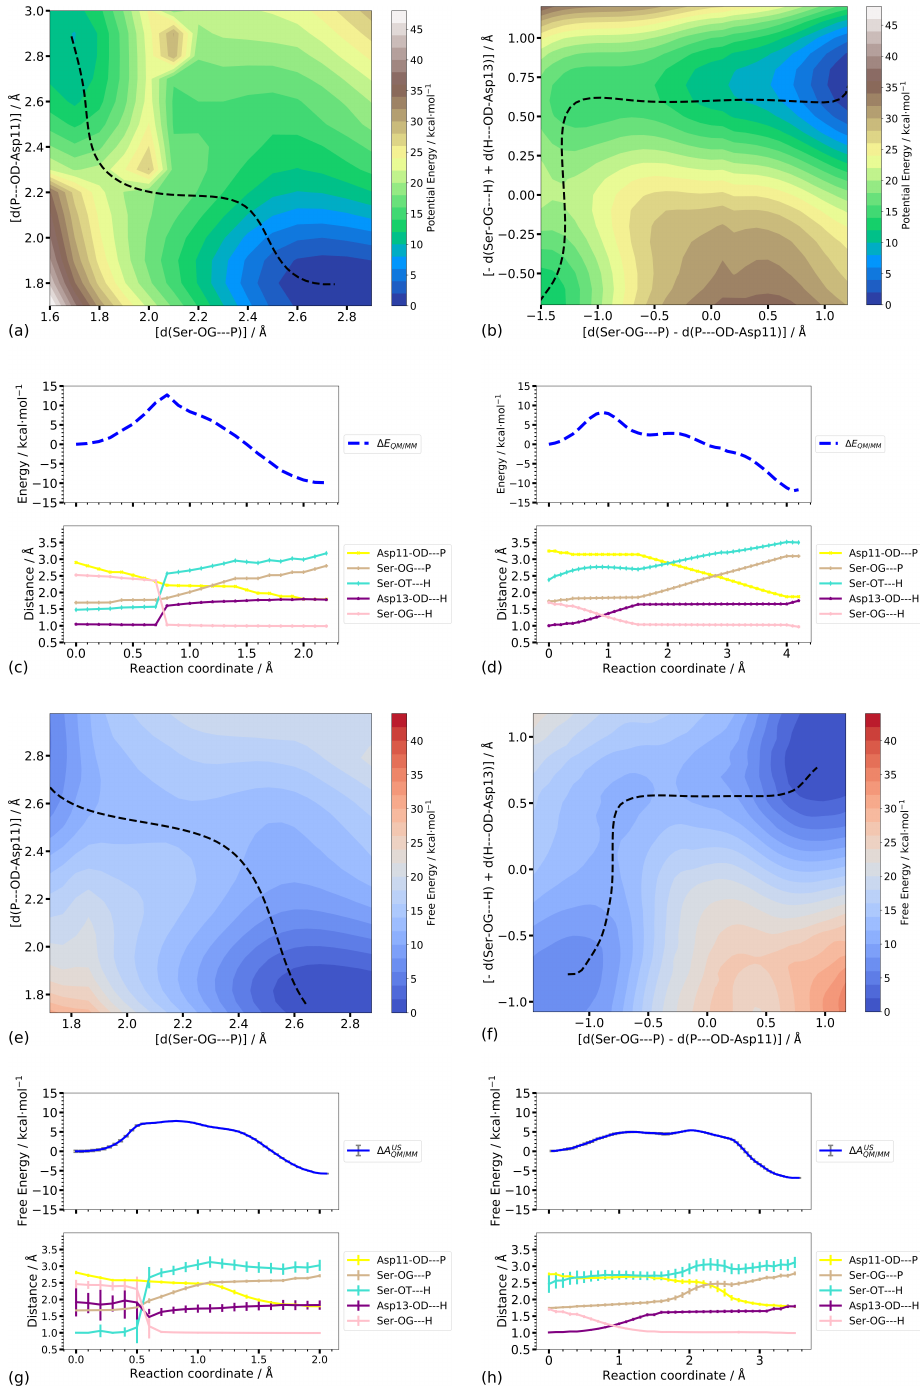
Figure 10. ( a , b ) Two-dimensional potential energy surfaces of Step 1. The dashed lines indicate the minimum energy pathway. ( c , d ) Energy profiles of the minimum energy paths in Step 1 (top) together with important distances (bottom). The reaction coordinate is the accumulated path lengths. ( e , f ) Two-dimensional free energy surfaces from umbrella sampling. The dashed lines indicate the minimum free energy pathways. ( g , h ) Free energy profile (top) together with important distances (bottom). The reaction coordinate is the accumulated path